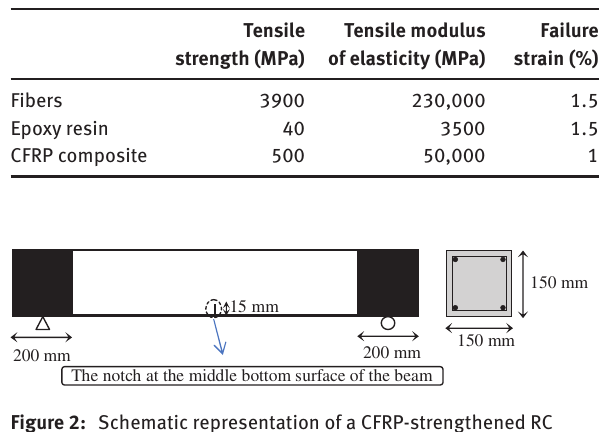
Figure 2: Schematic representation of a CFRP-strengthened RC